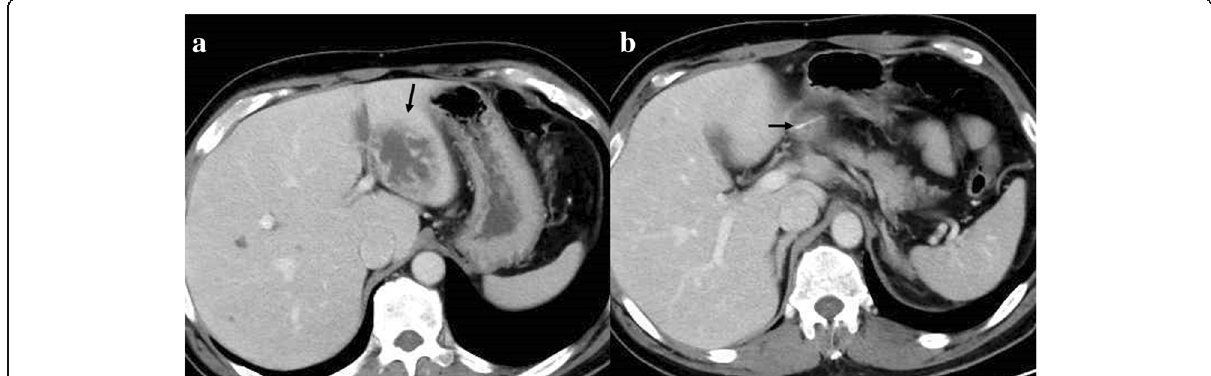
Fig. 2 Abdominal contrast-enhanced computed tomography findings. a A lesion with coexisting low- and high-density areas (black arrow) was found in the left lobe of the liver. b A hyperdense linear body (black arrow) was found in the liver